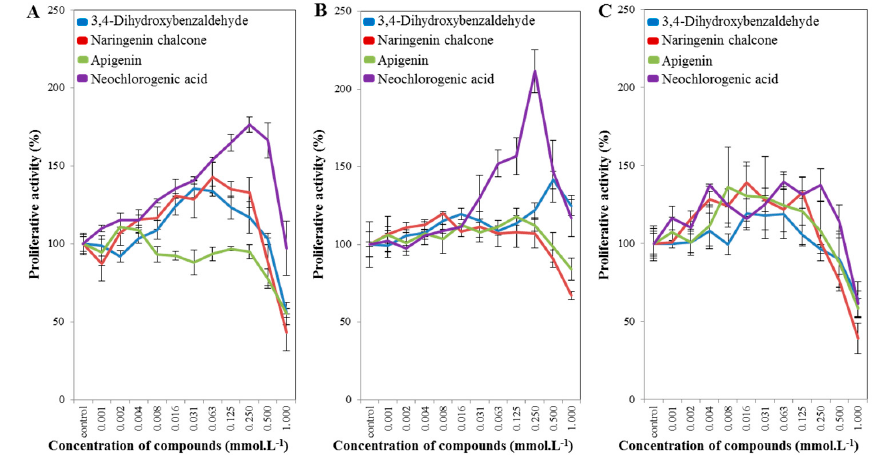
Figure 4. Results of the MTT assay for selected phenolic and flavonoid compounds: ( A ) for PNT1A cells; ( B ) for 22RV1 cells; and ( C ) for PC3 cells.